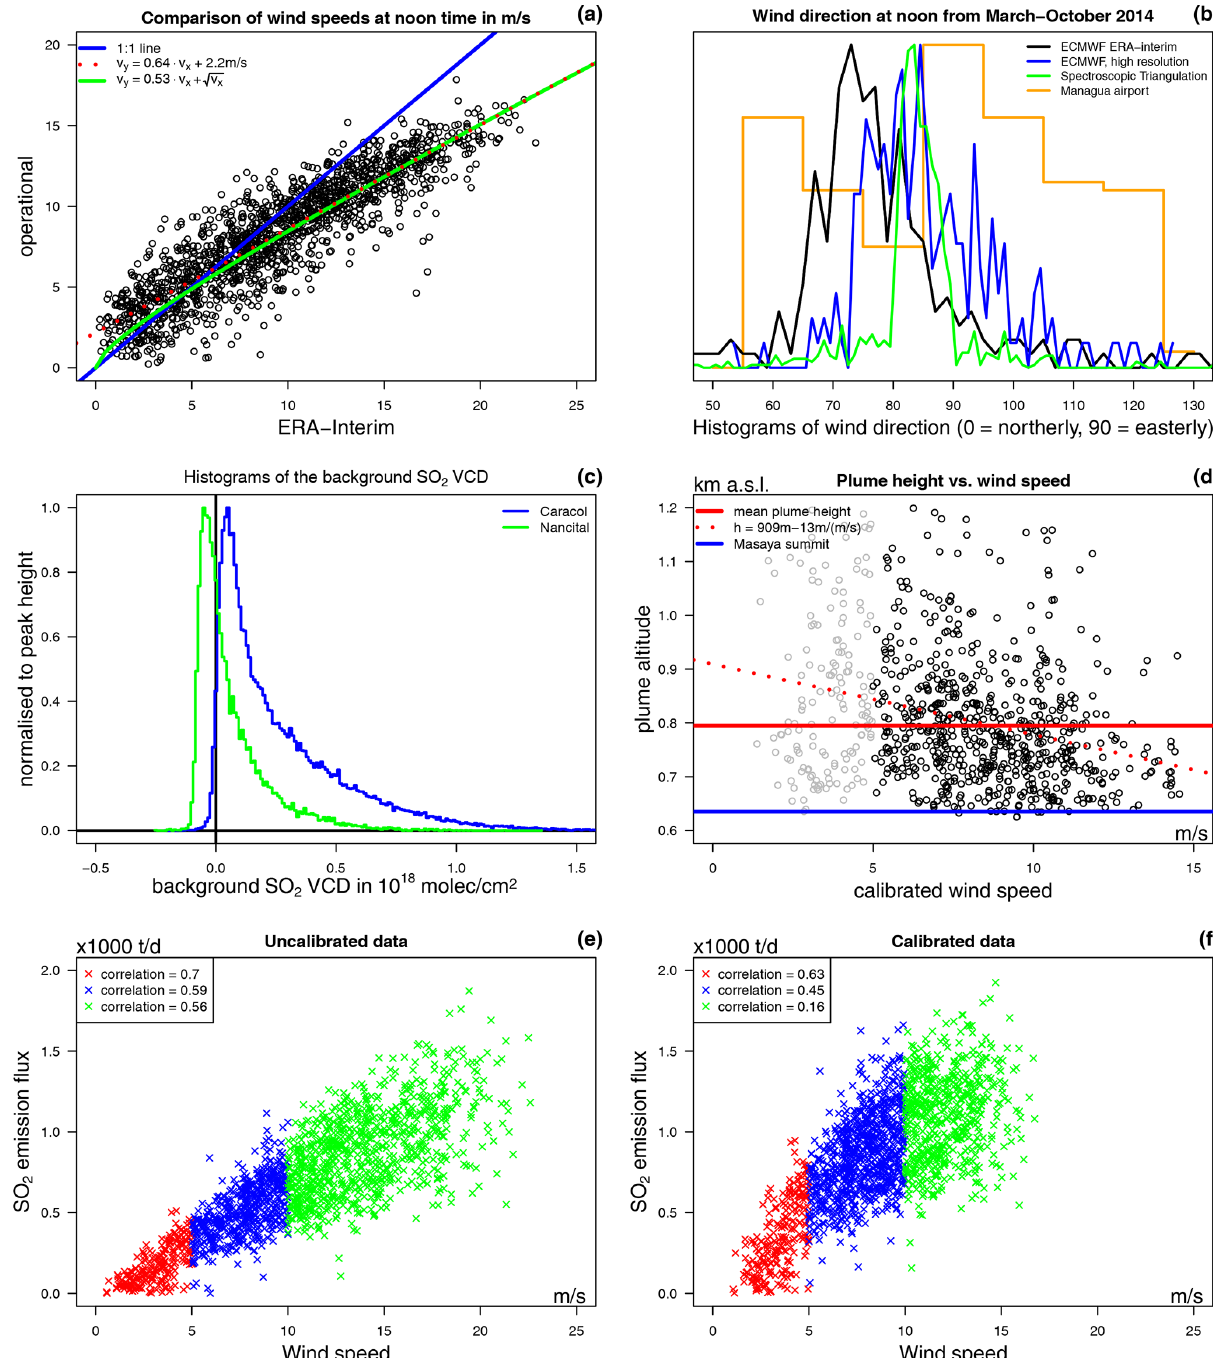
Figure 7. Summary of several empirical observations used for filtering and estimations. (a) Comparison of the wind speeds from the ECMWF ERA-Interim data and the operational ECMWF reanalysis data. (b) Comparison of the distribution of the wind directions estimated by four different methods. (c) Histograms of the absolute SO 2 SCD of the background spectrum for both instruments for their respective total time series. (d) Scatter plot of the triangulated plume height and the calibrated wind speed. The red dotted line indicates the relationship between wind speed and plume height (fit based on the black circles). (e, f) Correlation between the retrieved SO 2 emission fluxes and the wind speed. The plots compare daily SO 2 means and the means of the wind speed at the respective measurement times. (e) Original ERA-Interim wind speeds versus the non-calibrated SO 2 emission fluxes calculated with original ERA-Interim wind conditions and a fixed plume altitude of 635ma.s.l. (f) Calibrated wind speeds versus the SO 2 emission fluxes calculated with the calibrated wind conditions and a dynamic plume altitude as a function of the wind